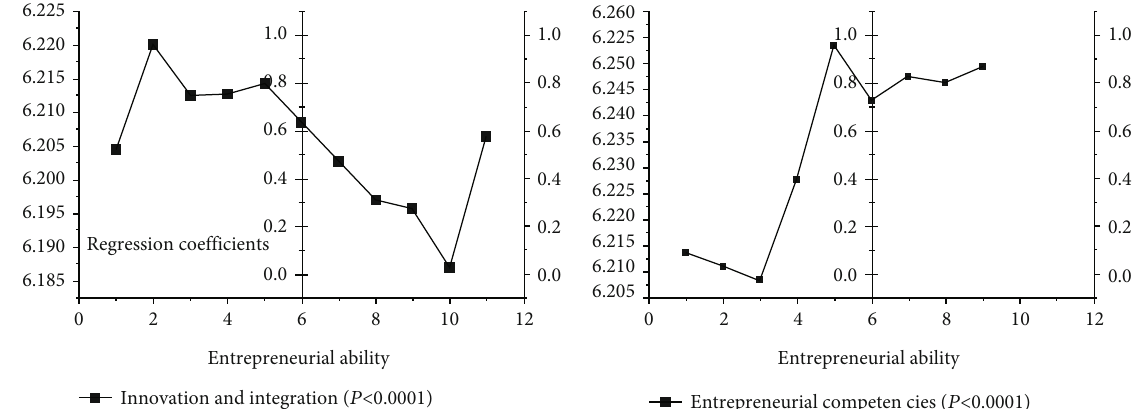
Figure 4: Regression coe ffi cients of di ff erent forms of dual-innovation education and entrepreneurship.